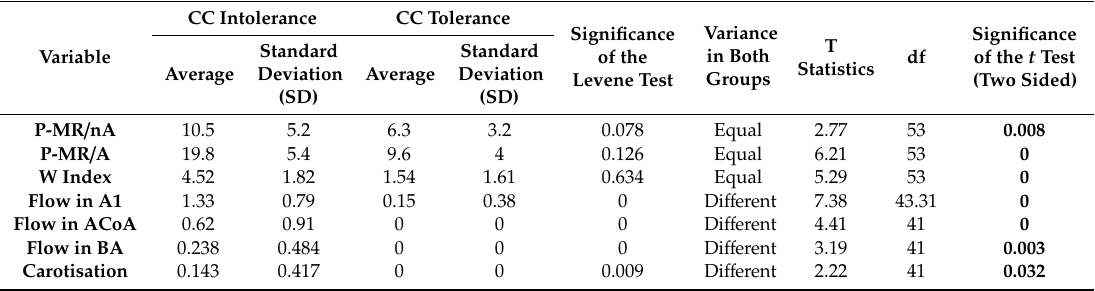
Table 3. CC intolerance and CC tolerance test in terms of variables being potential predictors of resistance to the CC. Comparison of Group I and Group II.